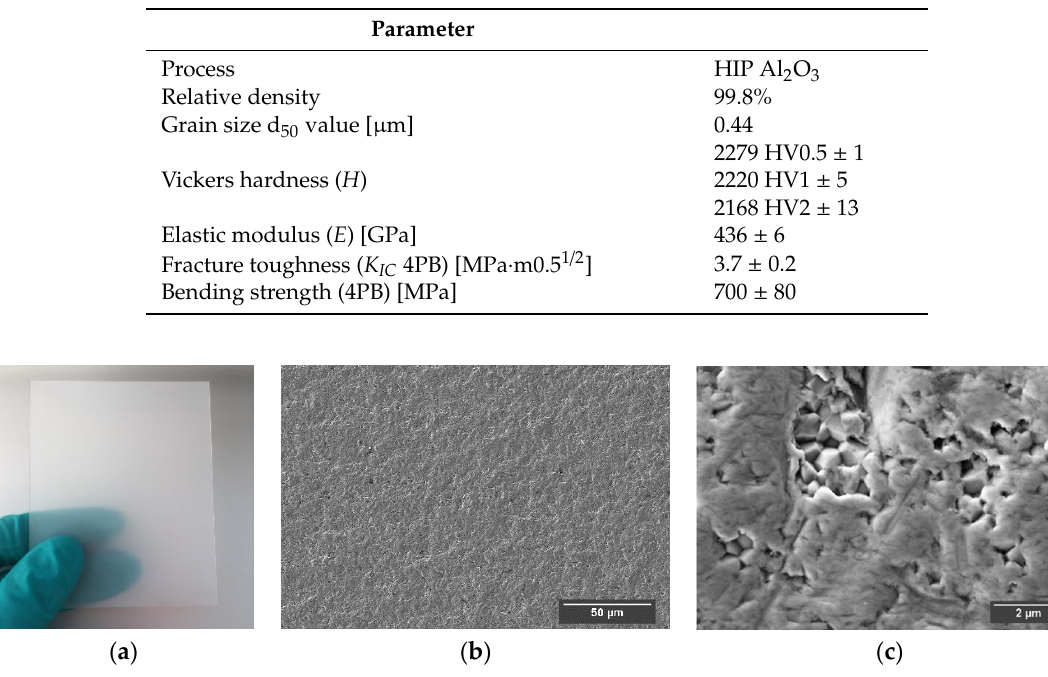
Figure 1. Field emission scanning electron microscopy (FESEM) image of the polished cross section of the used Al 2 O 3 ceramics. Table 1. Mechanical properties of the Al 2 O 3 ceramic material.